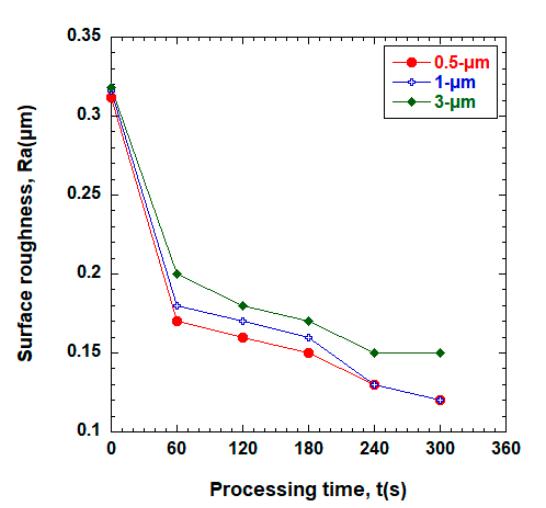
Figure 4. Surface roughness (Ra) vs. processing time for different diamond paste sizes (vibration: 8 Hz; rotation: 1500 rpm; sharp edge; gap: 3 mm).